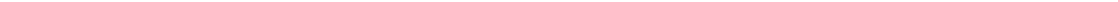
Testing samples of puri fi ed sulfolipids con fi rmed that tax-4 (but Fig. 1 Predator-released sulfolipids drive C. elegans behaviors. a C. elegans avoid excretions from starving P. paci fi cus PS (PS312, domesticated) and RS (RS5725B a wild isolate, predator cue) strains. Inset shows a schematic of the avoidance assay. b Top shows schematic of the modi fi ed egg-laying assay and bottom, C. elegans lay fewer eggs after a 30 min exposure to concentrated predator cue, but recovers after 2 h. c UHPLC-HRMS analysis reveals a complex mixture of >10,000 metabolites, which was subjected to multistage activity-guided fractionation using reverse-phase chromatography. After four fractionation steps, most of the activity ( ++ ) was found in fraction x. Averages and s.e.m. are shown. n > 30 for each condition. d UHPLC-HRMS ion chromatograms ( m / z value ± 5 ppm) of active fraction x and adjacent fractions for two sulfate-containing metabolites that were strongly enriched in the active fraction (left). MS – MS analysis (right) con fi rms presence of sulfate moieties in both compounds. e Schematic representation of 2D NMR-based comparative metabolomics (left) of consecutive fractions ( x − 2 to x + 2) used to identify signals speci fi c to fraction x . Cropped 2D NMR (dqfCOSY) spectrum (right) of active fraction highlighting signals that represent speci fi c features of the identi fi ed metabolites (gray lines de fi ne edges of shown subsections). f Chemical structures of metabolites identi fi ed via comparative metabolomics from active fraction x , sufac#1 and sufal#2. Gray arrows indicate important correlations observed in heteronuclear 2D NMR (HMBC) spectra. g Synthesis of sufac#1; THF: tetrahydrofuran. h Homologous metabolites sufac#2 and sufal#1 were also detected by UHPLC-HRMS. i Chemical structure of sodium dodecyl sulfate (SDS). Averages and s.e.m. are shown and number of animals tested are indicated on each bar or condition. * p < 0.05 obtained by comparison with controls using Fisher ’ s exact t-test